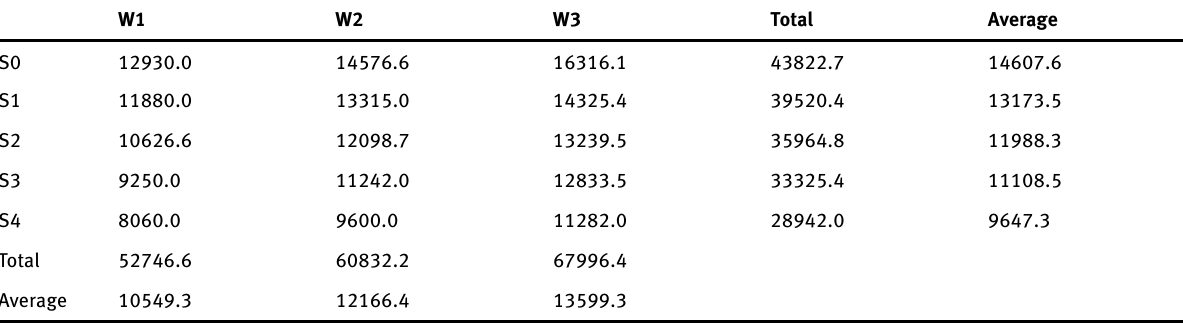
Figure 1: Total amount of evapotranspiration for the experiments Table 2: Average evapotranspiration rates of